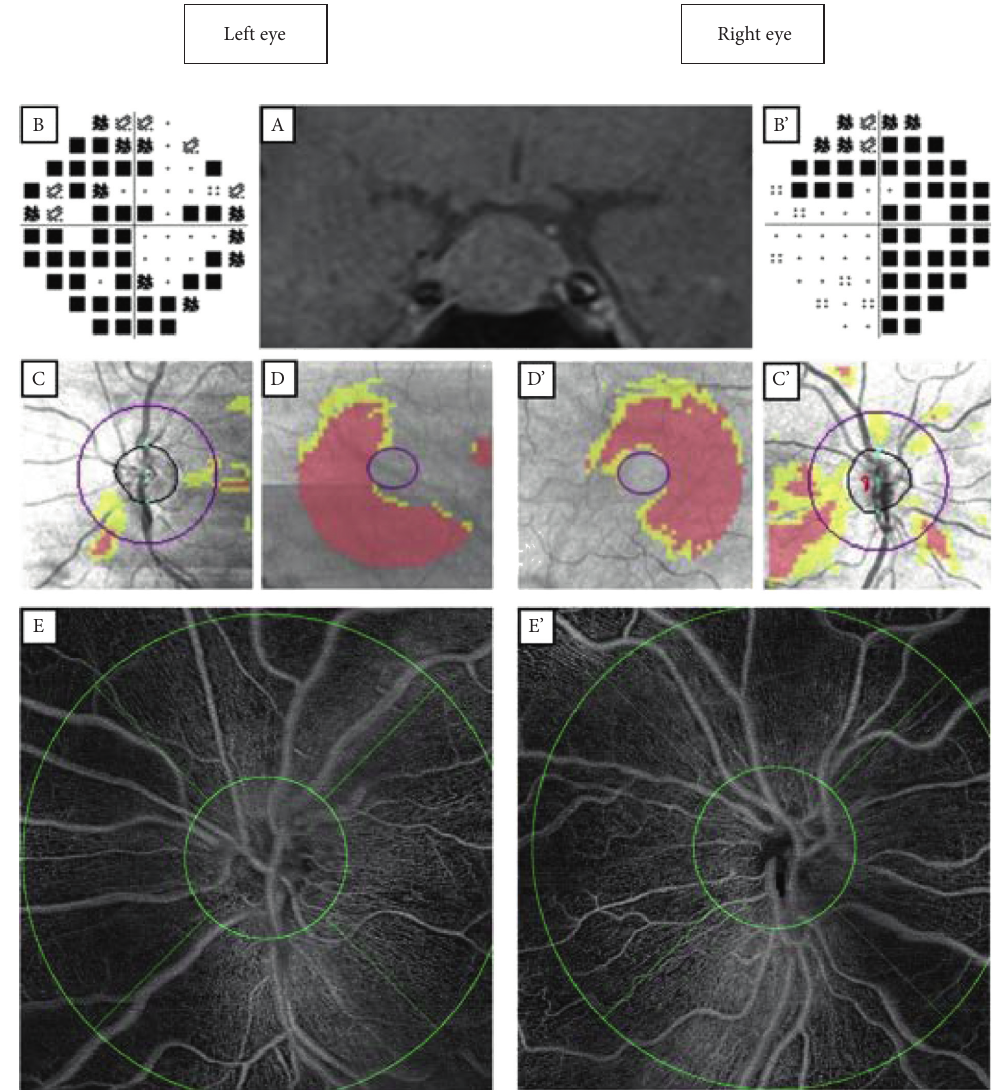
Figure 1: Multimodal analysis of a patient with a large pituitary adenoma with bilateral optic neuropathy. (A) Brain T1 magnetic resonance imaging showing a large pituitary adenoma with a mass effect on the optic chiasm. (B, B ′ ) Bitemporal hemianopsia on the Humphrey visual field (30–2). (C, C ′ ) Retinal nerve fiber layer thickness map. (D, D ′ ) Ganglion cell complex analysis. (E, E ′ ) “En face” optical coherence tomography angiography, 6 × 6 mm, with early treatment diabetic retinopathy study